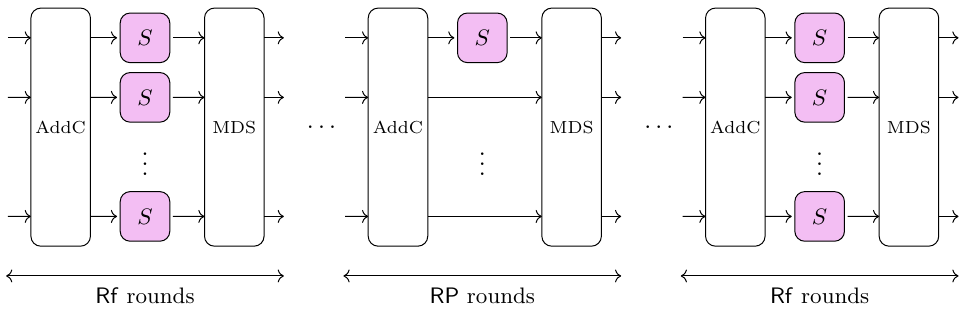
Figure 5: Overview of the construction of Poseidon